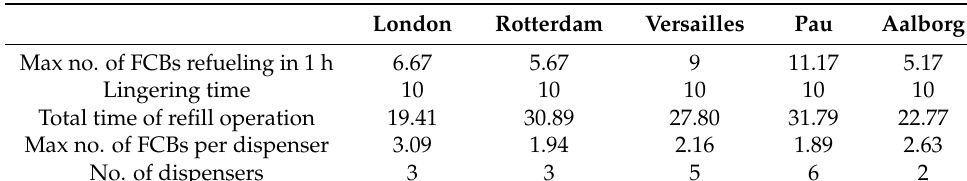
Table 5. HRS parameters considered for dispenser numbers.